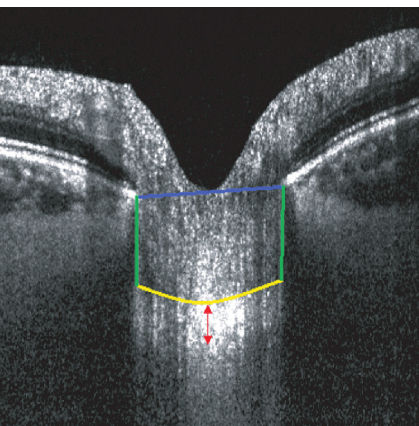
Figure 4: OCT B-scan showing the points used to compute the LCD. Line D in blue connects the two Bruch’s membrane opening (BMO) edges. The two lines perpendicular to D in green are defined from the BMO edges to the anterior LC insertion points. The anterior LC surface is demarcated in yellow, enclosing the area S where the LC is measured. The red arrow measures the distance between the anterior and posterior margins of the LC, defined as the